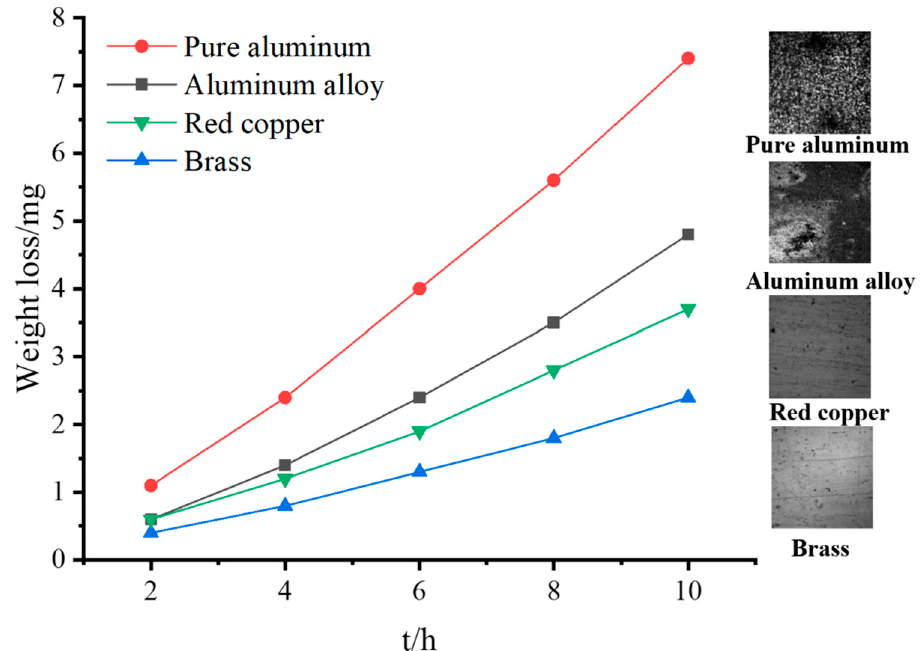
Figure 4. The weight loss of different metallic materials samples vs. acting time.